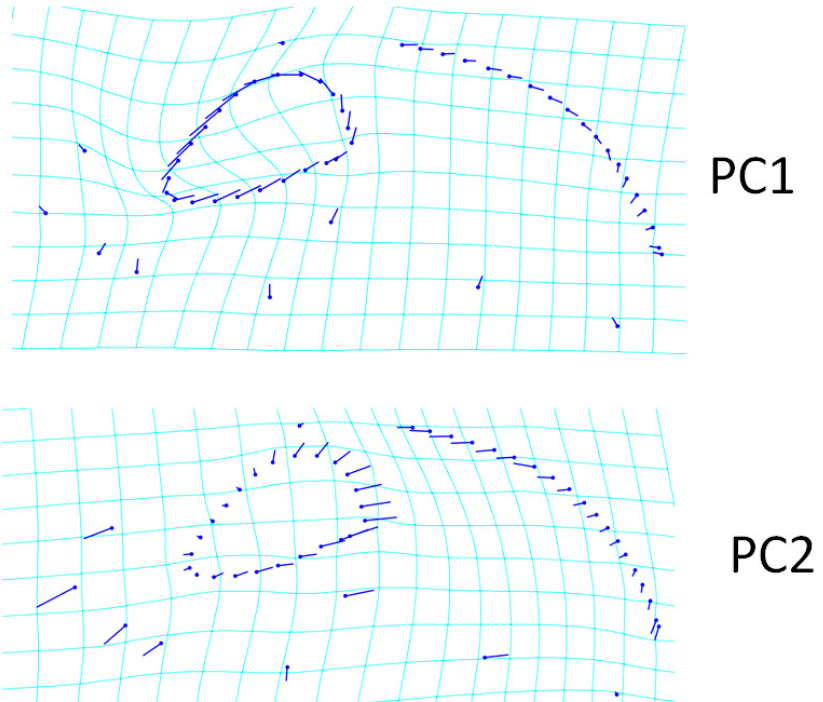
Figure 3. Transformation grid of changes in skull shape of PC1 (32.39%) and PC2 (18.45%) (lateral view). Transformation grids illustrate the shape changes from the overall mean along PC1 and PC2. The length of the lines extending from the points represents the amount and direction of change.